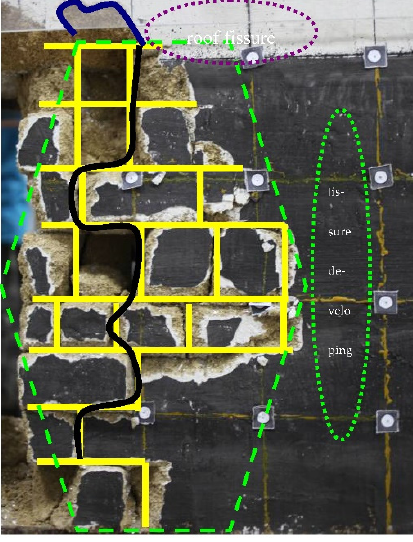
Figure 10. Development of joint and instability form the coal wall rib-spalling ( α = 90 ◦ , non-through seam).